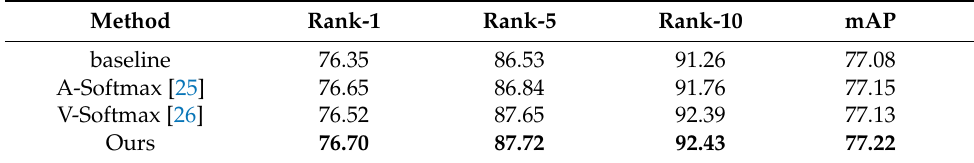
Table 5. Comparison experiments on VRAI.